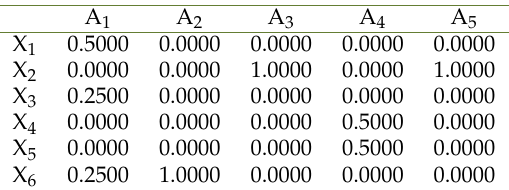
Table 3. Normalized decision matrix